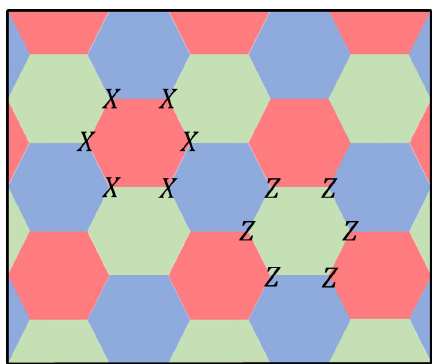
Figure 9: The 2D color code is defined on the honeycomb lattice with one physical qubit per vertex. For each plaquette, there are two stabilizers given by the product of either X or Z operators on the vertices forming the